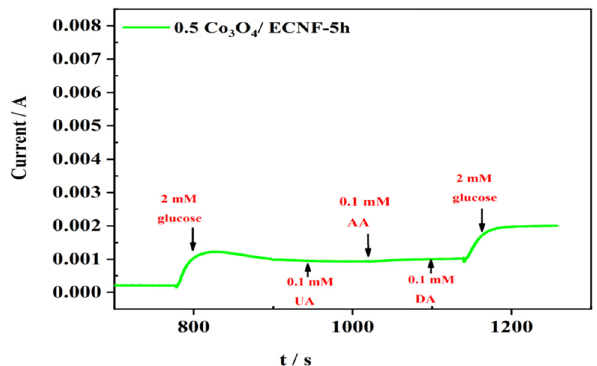
Figure 8: Amperometric response of Co 3 O 4 /ECNF composite elec - trode to the addition of 0.1 mM of di ff erent interferent ’ s analytes in the presence of glucose analyte in 0.1 M NaOH